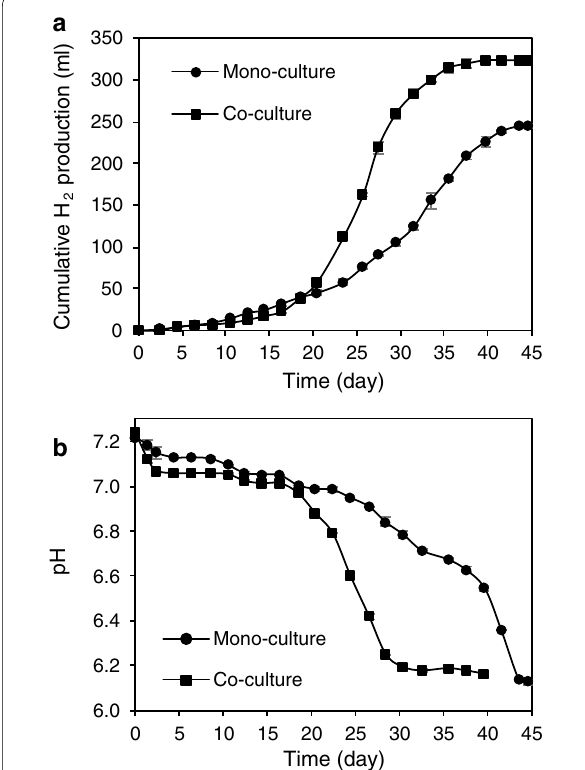
Fig. 2 C. termitidis mono‑cultured in 2 g l − 1 cellulose and co‑cultured with C. beijerinckii 2 g l − 1 cellulose. a Cumulative H 2 production profiles. b pH profiles. Data points are the averages of duplicates,